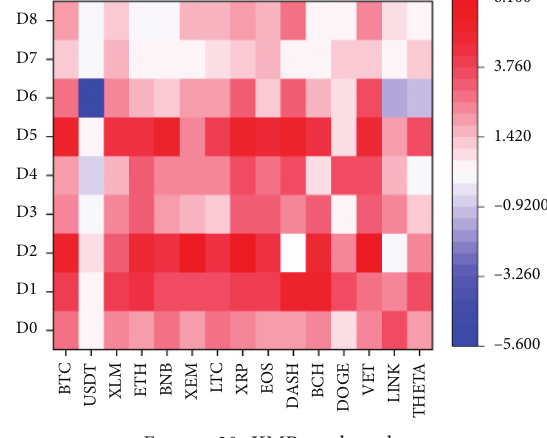
Figure 20: XMR to the other.